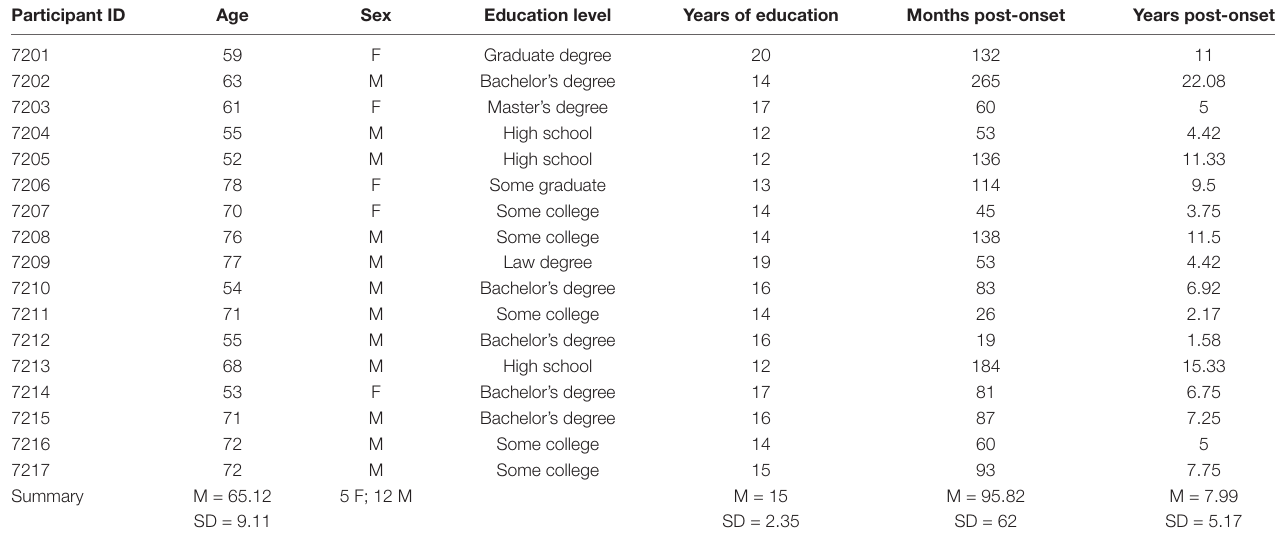
TABLE 1 | Demographic characteristics of participants with aphasia.